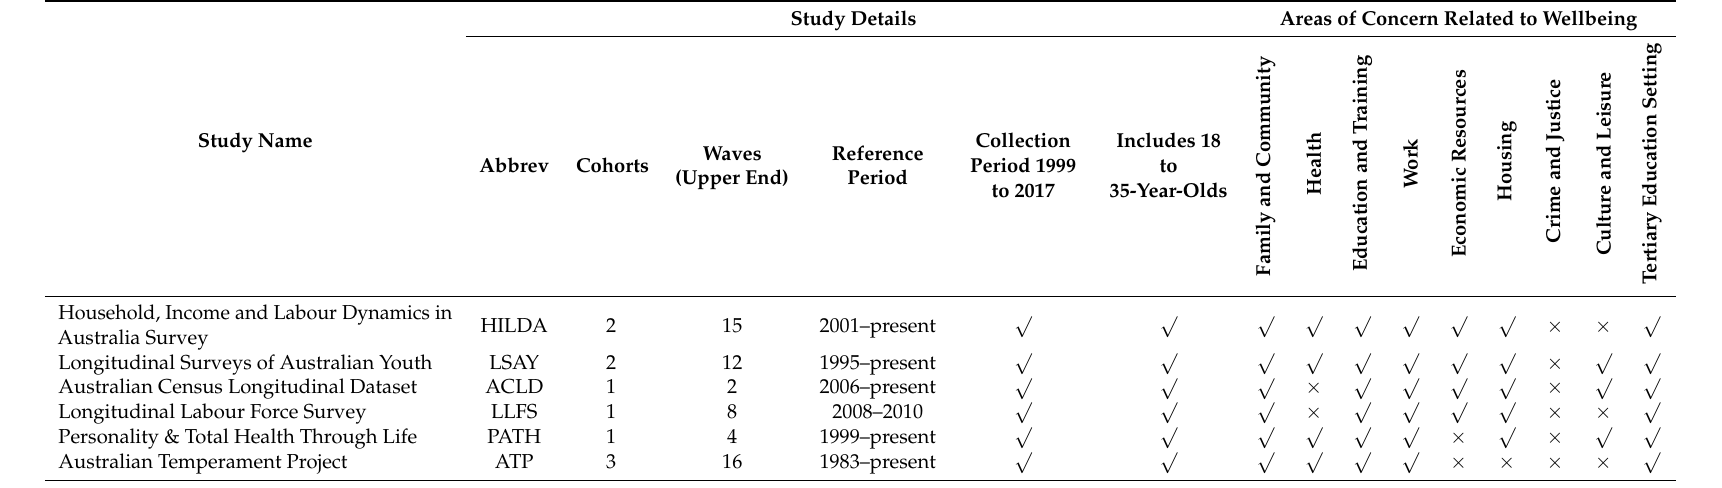
Table 3. Study name and details of longitudinal studies collecting data on areas of concern impacting wellbeing of Australian young